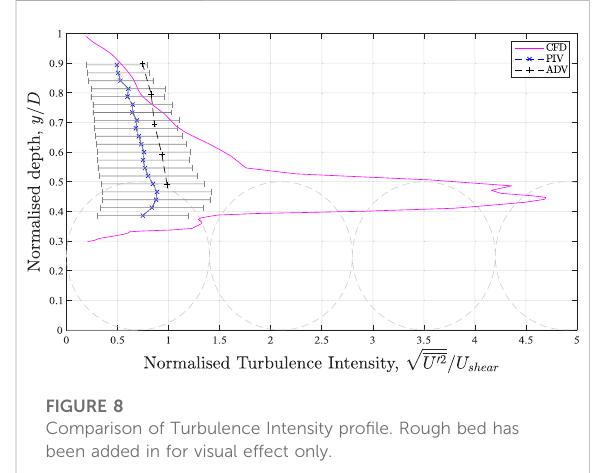
FIGURE 8 Comparison of Turbulence Intensity pro fi le. Rough bed has been added in for visual effect only.